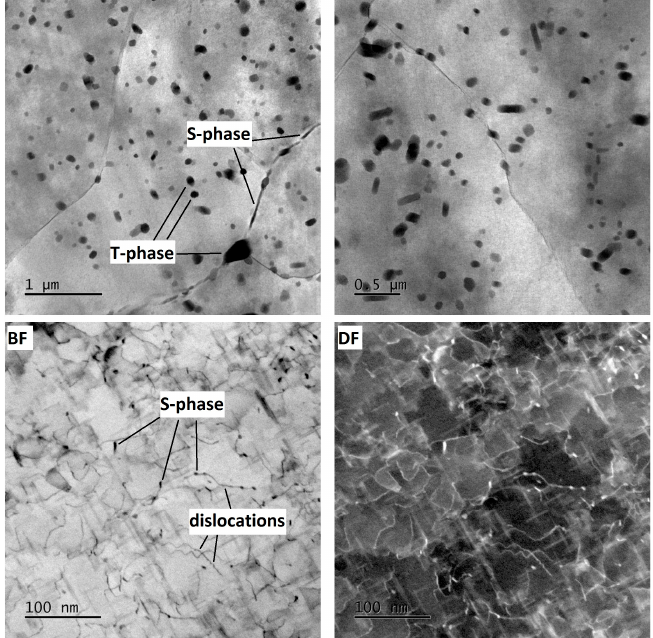
Figure 12. Micrographs of specimen W-1RS-160 at different magnification with marked dislocations, T-phases and S-phases.